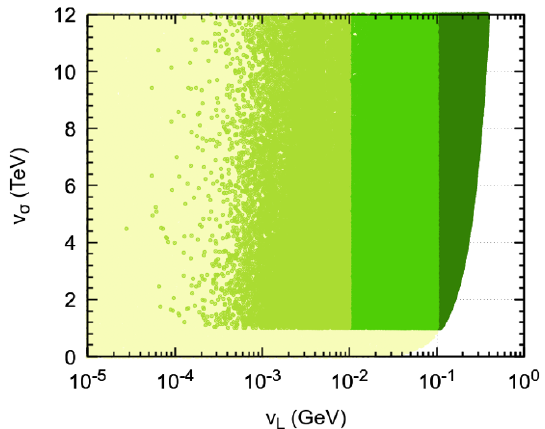
Figure 2 . v (cid:27) as a function of v L . The yellow region is the set of values of ( v (cid:27) ; v L ) that satisfy eq. (5.3) without any other constraint. The other points, in shades of green, satisfy all the other theoretical and experimental constraints. For these, the color code is as follows: the points in dark green have v L > 0 : 1 GeV, those in green have v L 2 [0 : 01 ; 01]GeV and those in yellow green have v L < 0 : 01 GeV. In our scans a cut v (cid:27) > 1 TeV, was imposed. See text for further